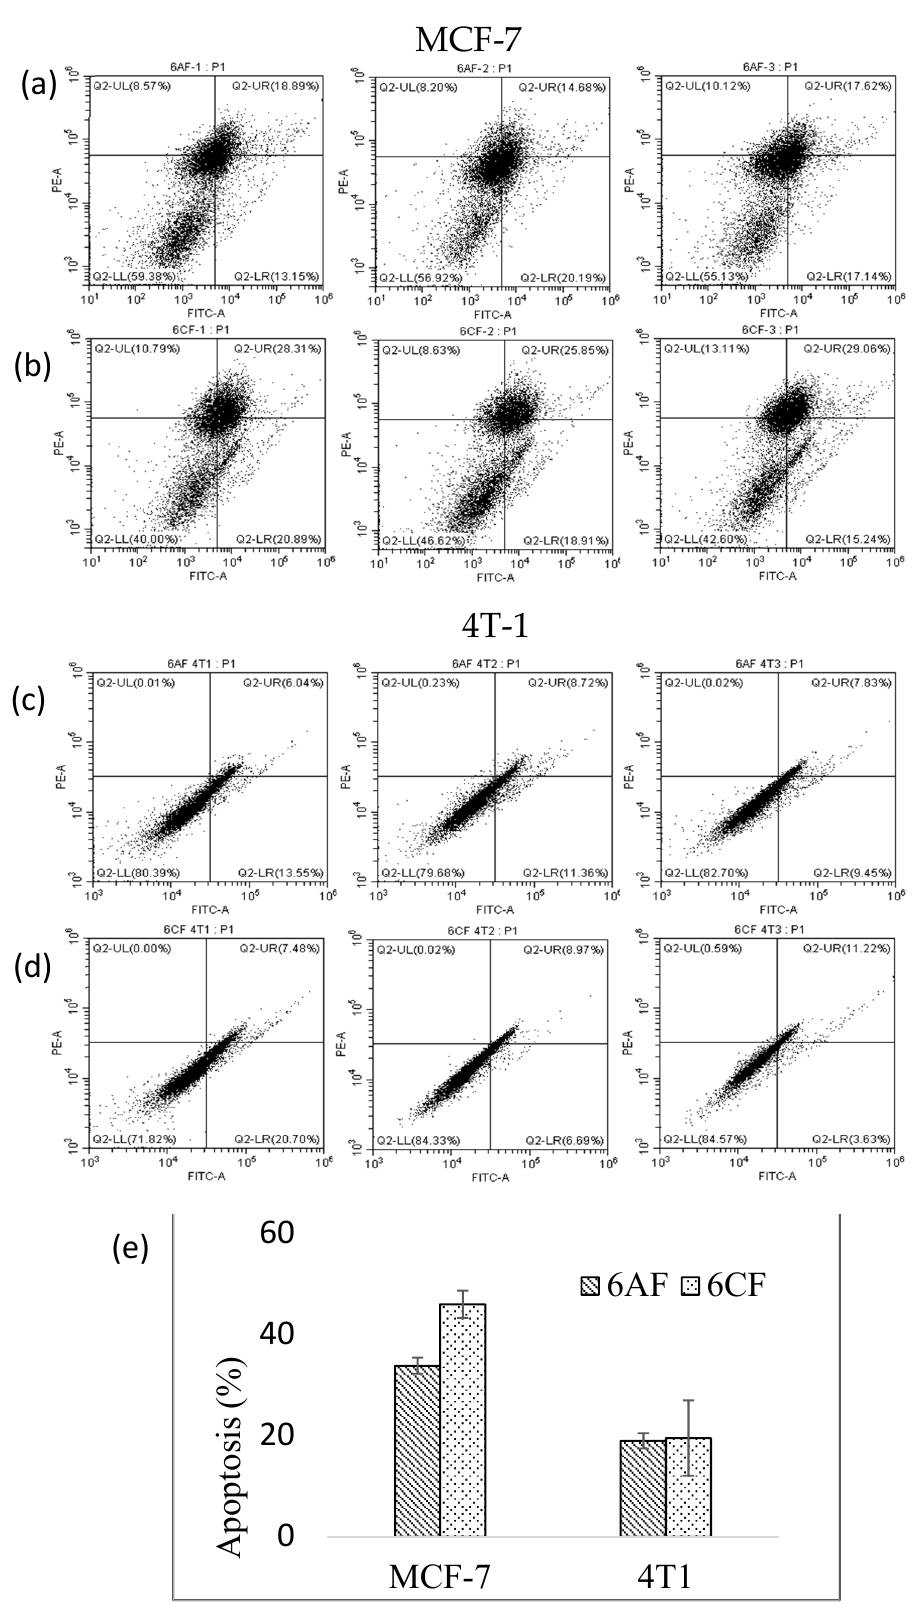
Figure 3. Apoptosis assay of 6af and 6cf in MCF-7 and 4T1 cells. ( a and b ) Flow cytometry plots for apoptosis in MCF-7 cells treated with 6af and 6cf , respectively. ( c and d ) Flow cytometry plots for apoptosis in 4T1 cells treated with 6af and 6cf , respectively. Upper left (necrotic cells), lower left (live cells), lower right (early apoptotic cells) and upper right (late apoptotic cells). ( e ) Graph showing the apoptosis (%) induced by 6af and 6cf in MCF-7 and 4T1